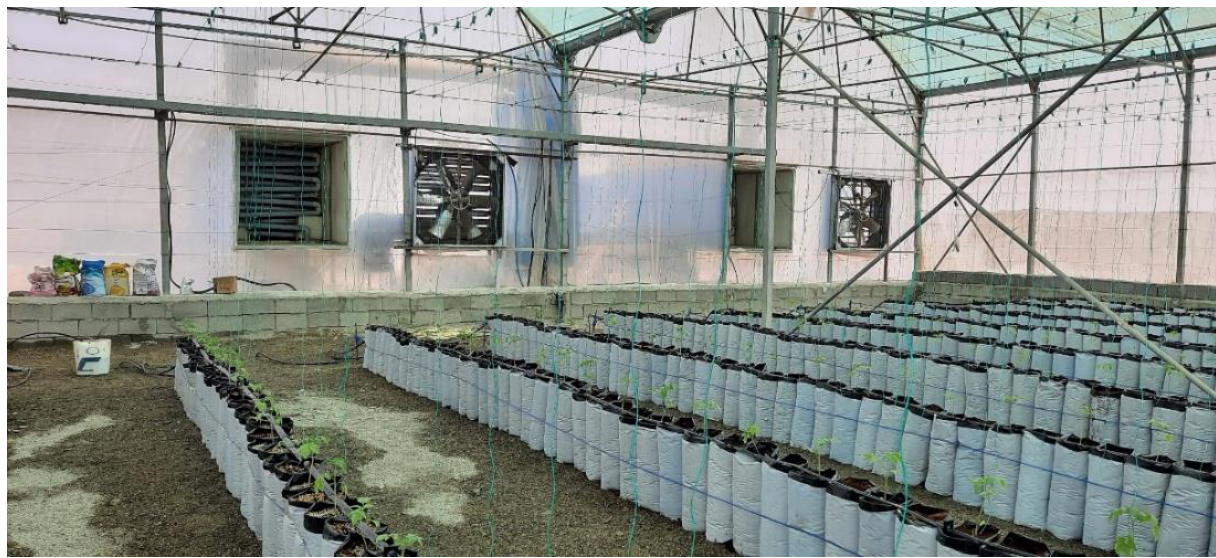
Figure 6. The position of ventilation fans installed in the seawater greenhouse.